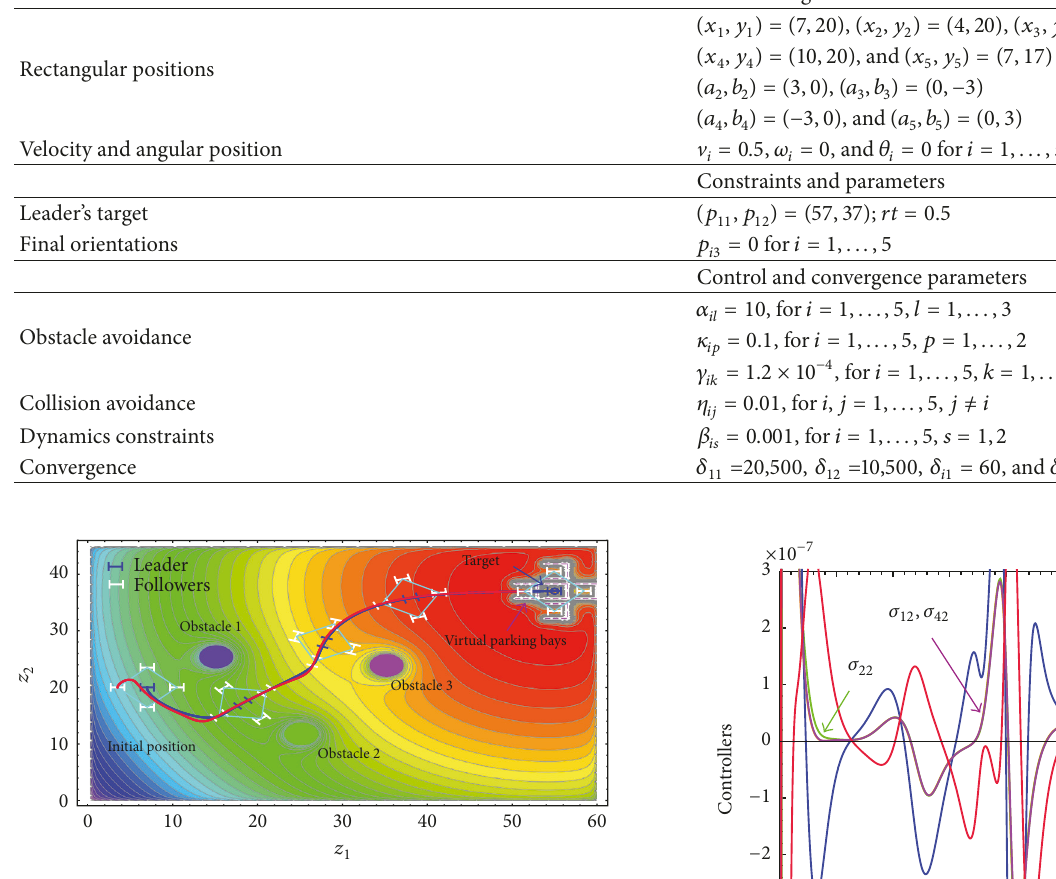
Figure 12: The evolution of the 5-robot C-ITS and the contour plot in the presence of obstacles in Scenario 3.